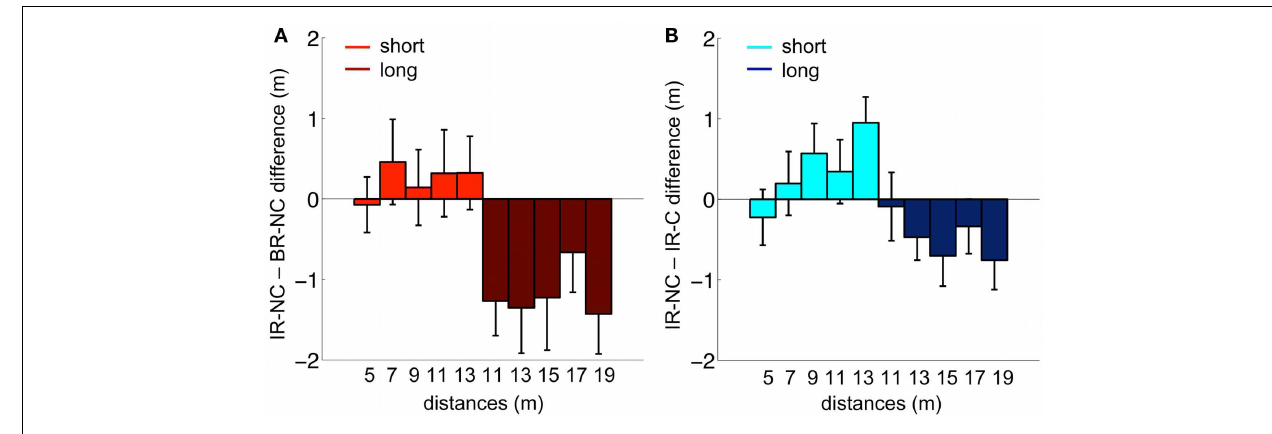
conditions for mean reproduced distances.The only difference between the two conditions was the symbolic cue. Colors code the “short” and “long” range of displacements